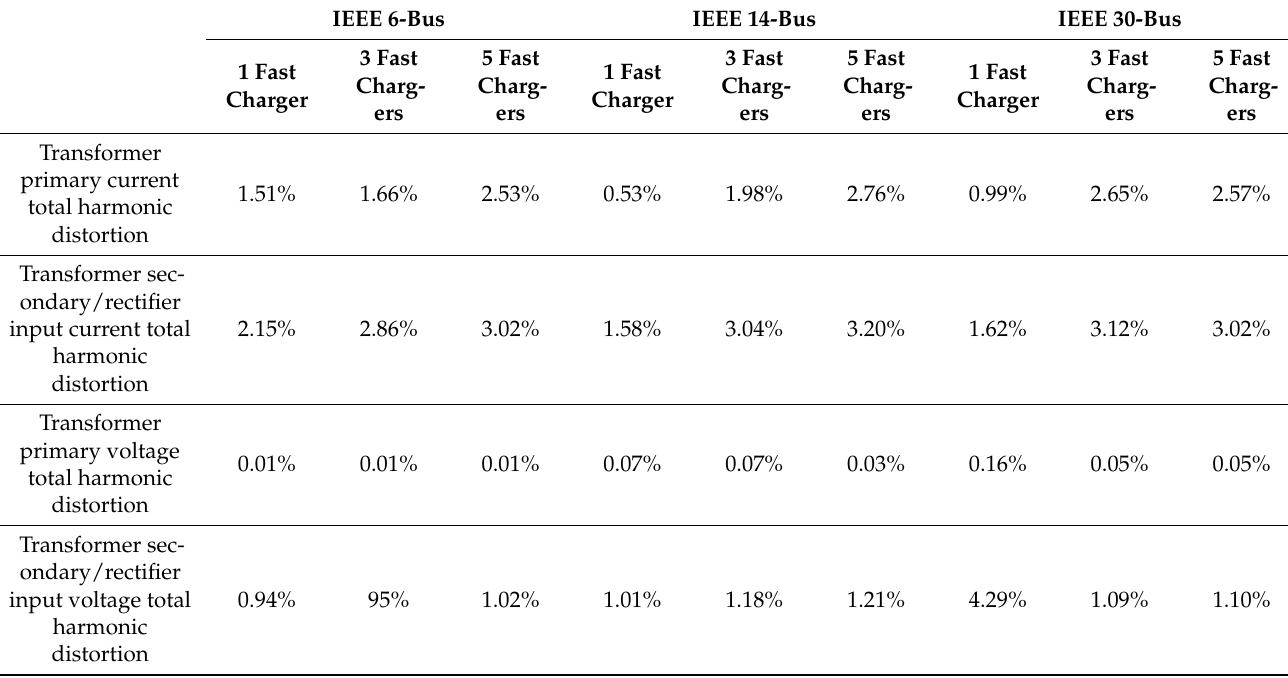
Table 5. EV fast charger effect THD values in IEEE 6-bus, 14-bus, and 30-bus test systems. IEEE 6-Bus IEEE 14-Bus IEEE